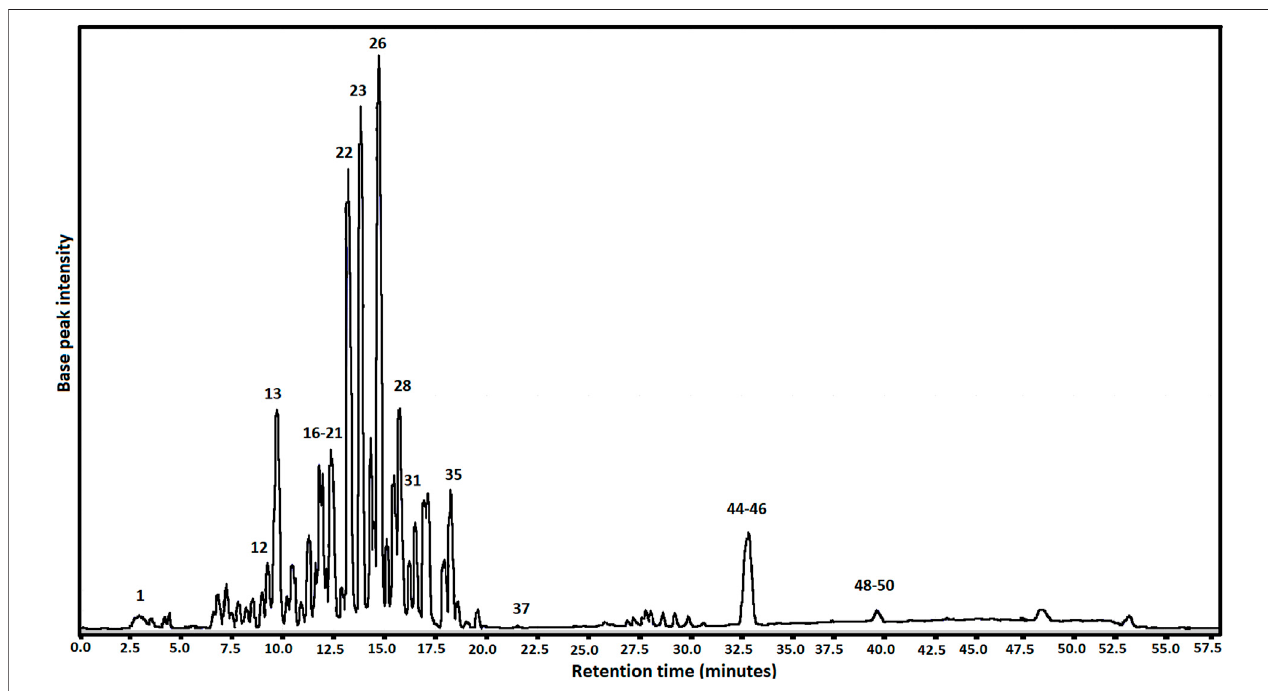
FIGURE 1 | EABRP LC-ESI-Orbitrap-FTMS